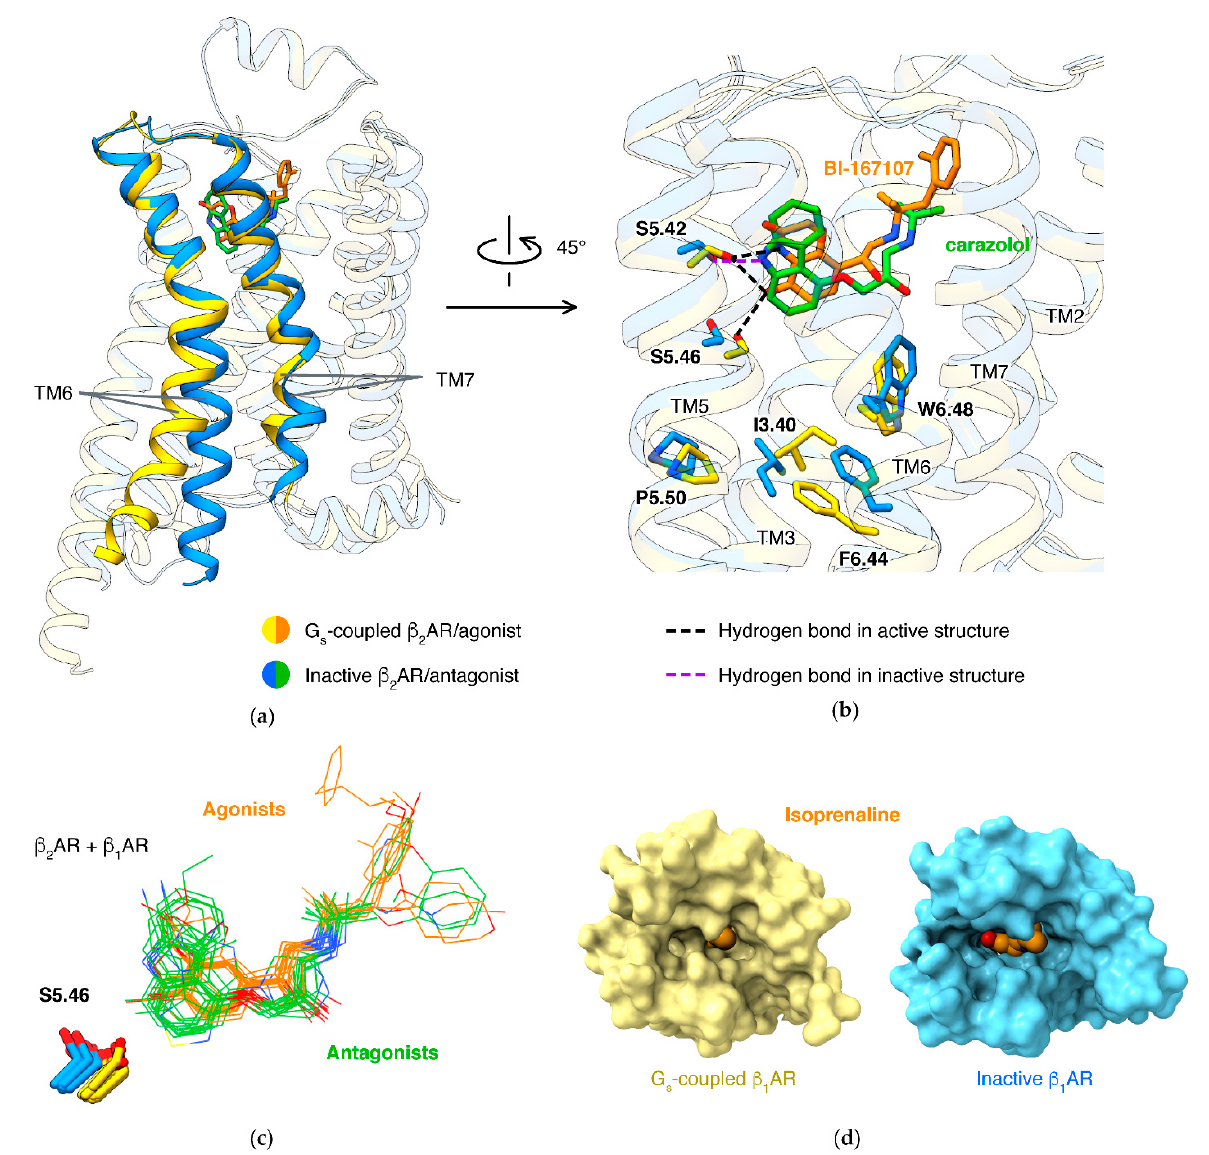
Figure 4. Mechanism of agonism in β adrenergic receptors. ( a ) Structures of β 2 AR in active/inactive states (PDB IDs: 3SN6 [8], 2RH1 [6]). ( b ) Interactions of agonist/antagonist to S5.42/S5.46 and microswitch of P5.50-I3.40-F6.44 motif. ( c ) Binding poses of agonists/antagonists in β 1 AR/ β 2 AR [6,8,11,31,43,54,66–77]. Structures were aligned based on C α atoms of 7 residues: 3.32; 5.42,46; 6.51–52; 7.40,43. ( d ) Binding poses of isoproterenol in β 1 active/inactive states (PDB IDs: 7JJO [66], 2Y03 [67] ).